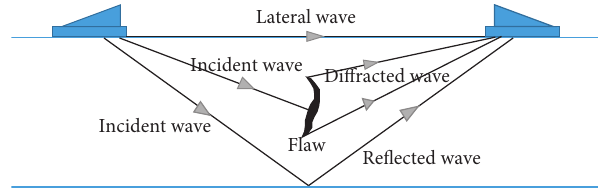
Figure 4: Principle of TOFD acoustic